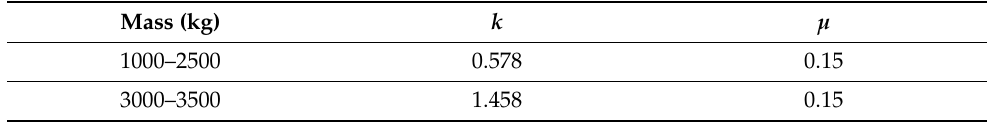
Table 2. Drag coefficient and rolling factor for